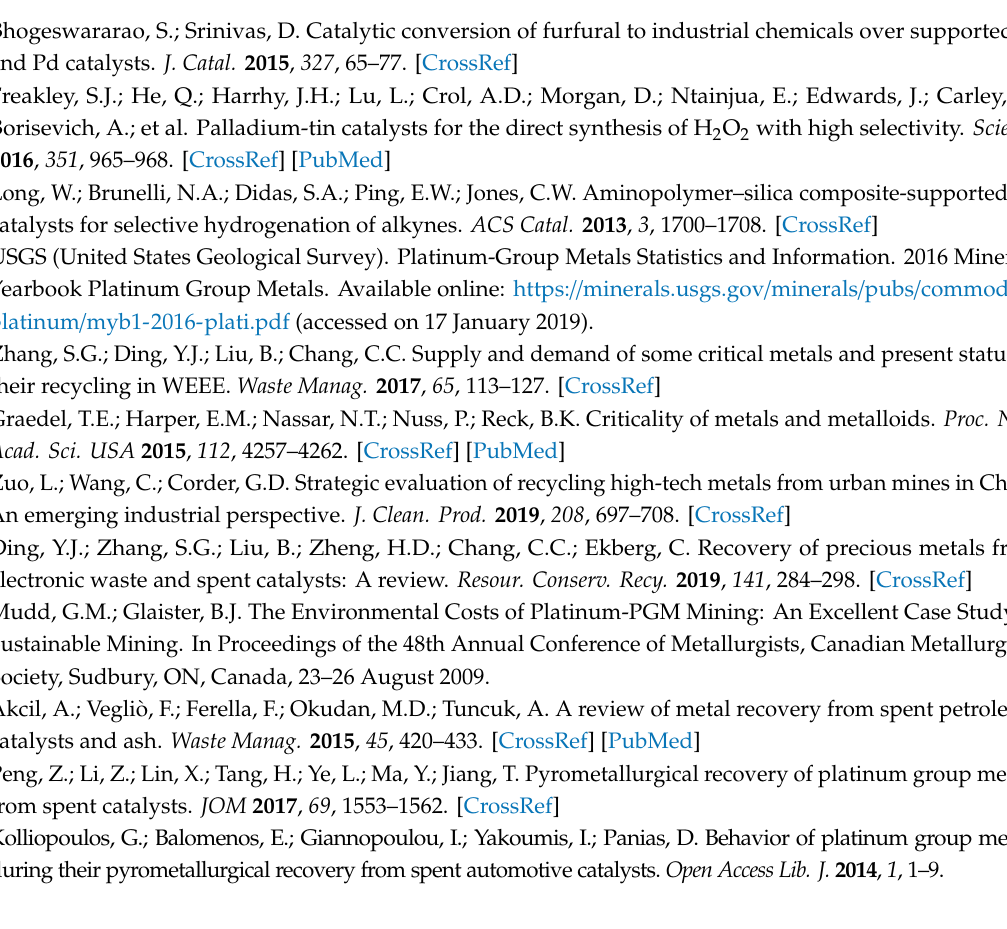
Figure S1: The reduction potentials for PdCl 42 − in chloride media at the concentration of 0.001, 0.01, and 0.1 mol / L. Figure S2: The organics recovered from spent catalysts by distillation. Figure S3: XRD patterns of the spent catalysts before and after distillation. Figure S4: The infrared spectra of recovered products by distillation, (a) solid product and (b) liquid product. Figure S5: Plots of x vs. t at di ff erent reaction temperatures. Figure S6: Plots of 1 − 3(1 − x) 2 / 3 + 2(1 − x) vs. t at di ff erent reaction temperatures. Figure S7. Arrhenius plot for the leaching of Pd from spent catalysts calculated by the ash layer di ff usion model. Table S1: Kinetics parameters during the leaching process calculated by the mass transfer control model. Table S2. Kinetics parameters during the leaching process calculated by the ash layer di ff usion model. Table S3. The e ff ect of Fe 3 + on the adsorption e ffi ciency of Pd by R 410 ion exchange resins. Table S4. The e ff ect of H + on the adsorption e ffi ciency of Pd by R 410 ion exchange resins. Table S5. Elution e ffi ciency of Pd from loaded resins by using di ff erent reagents. Table S6. The desorption e ffi ciency of Pd by NH 4 Cl + NH 3 . Table S7. The leaching e ffi ciency of Pd by reusing leaching